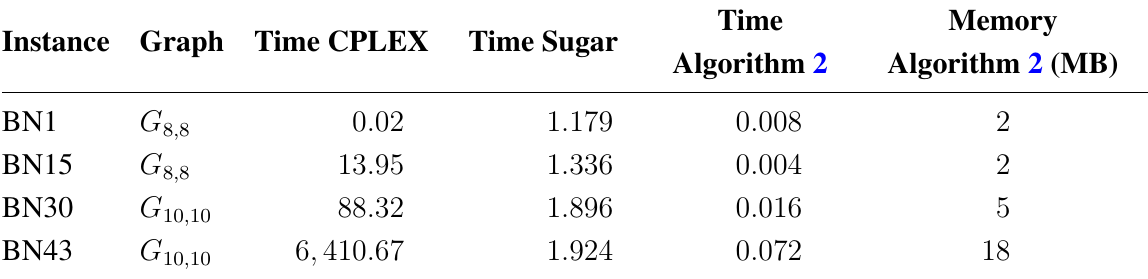
Table 1. Running time in seconds for solving Numberlink. Our algorithm could not solve C88 due to insufficient